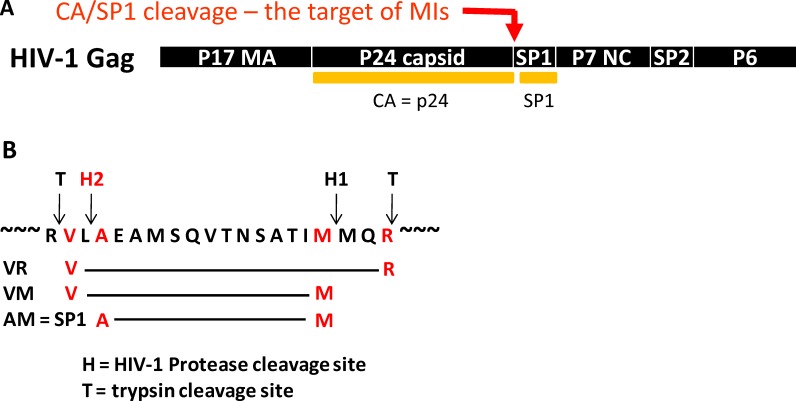
Schematic for Cleavage of CA/SP1.A) Schematic for the processing HIV Gag at CA/SP1 and SP1/NC sites by HIV-protease. B) Detail of the cleavage region around CA/SP1 showing sites for HIV-1 protease cleavage (H1 and H2) and sites for subsequent cleavage by trypsin (T).